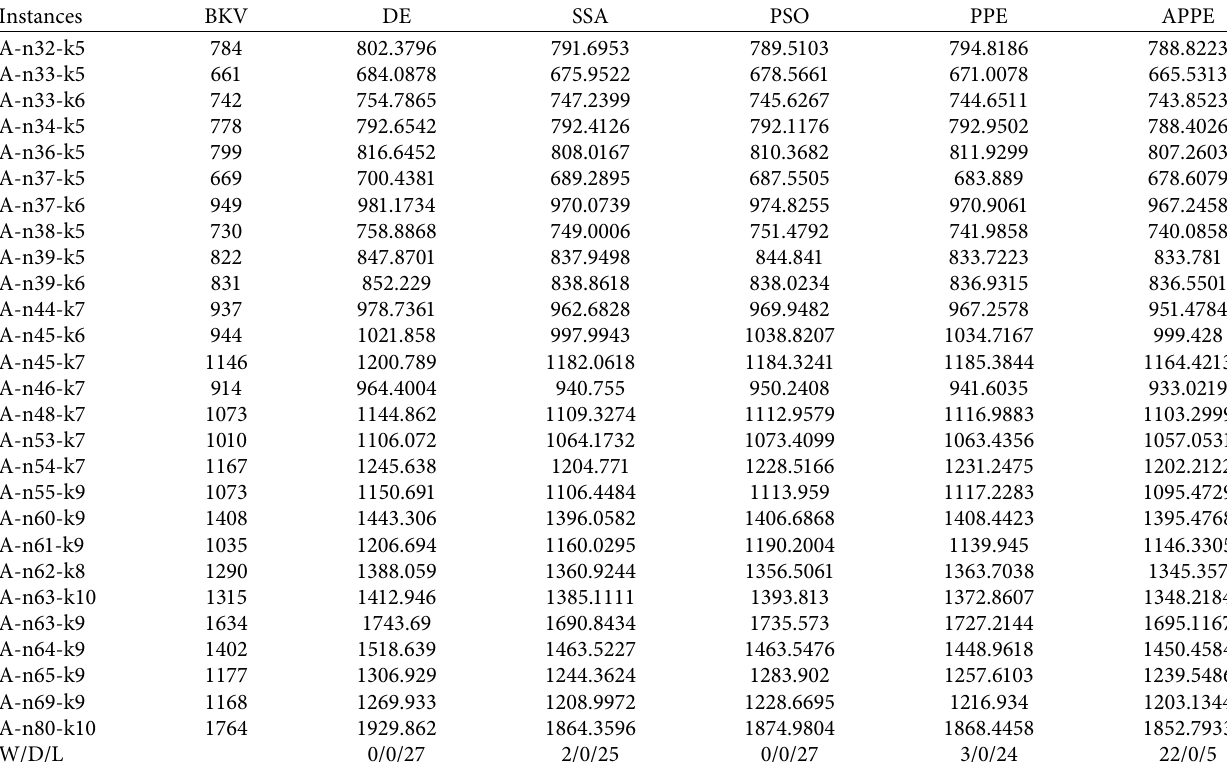
Table 15: Comparison of the mean result of 10 runs in CVRP